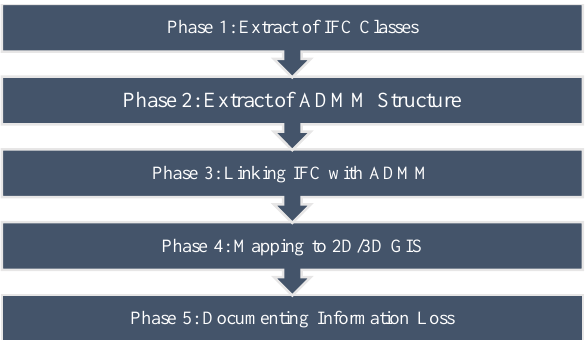
Figure 4 . Semantic Output in